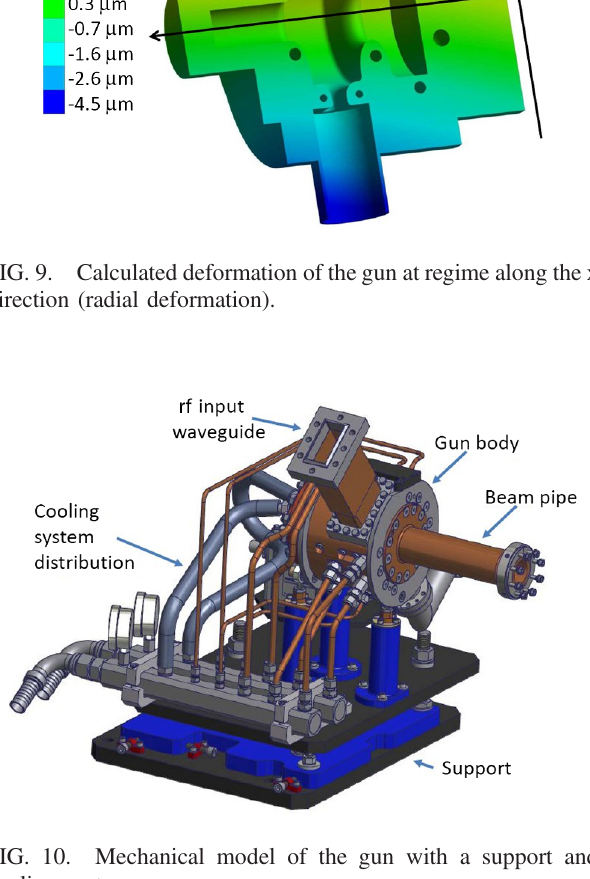
FIG. 10. Mechanical model of the gun with a support and cooling